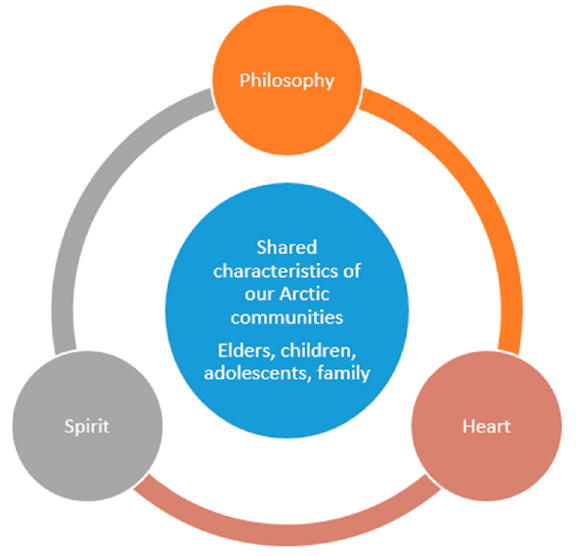
Figure 1. Shared characteristics of Arctic communities as discussed in the Sharing Circle.